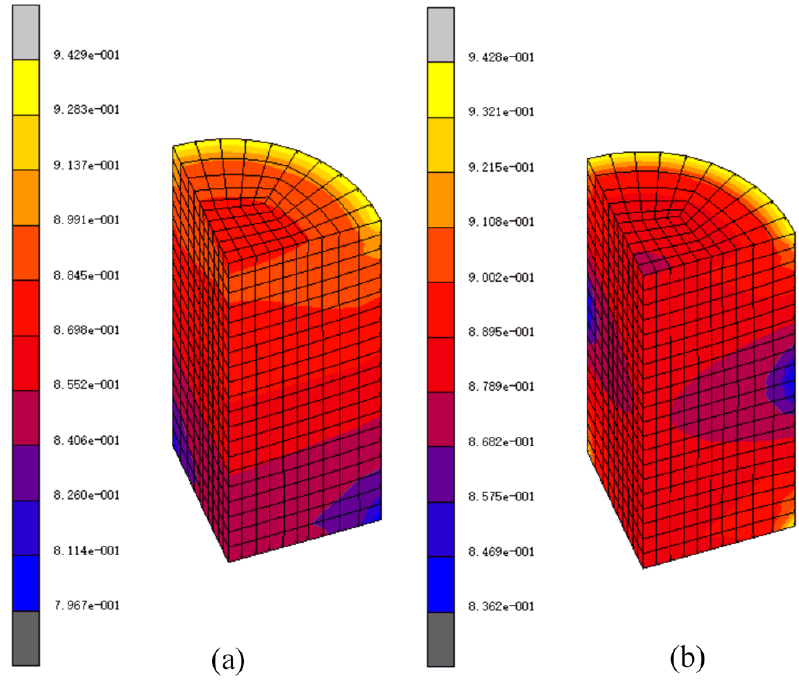
Figure 8. Comparison of the relative densities of the Cu–Al mixed metal powders during a ( a ) single ‐ action die compaction and ( b ) double ‐ action die compaction.